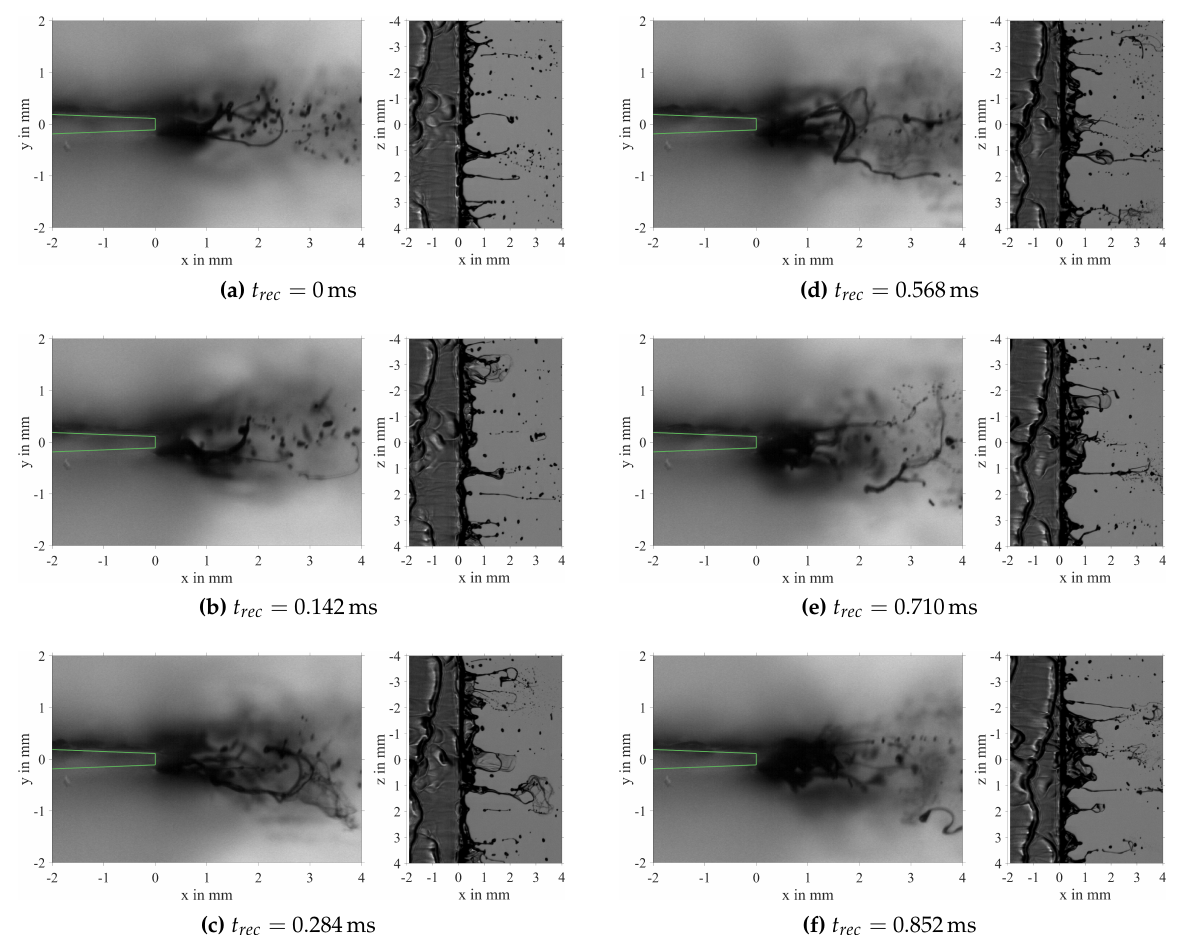
Figure 7. Shadowgraphy images of the liquid breakup at the prefilmer tip in side view perspective (first and third column) and top view perspective (second and fourth column) for p g = 1bar, u g = 70m/s, h a = 230µm, ˙ V / b = 25 mm 2